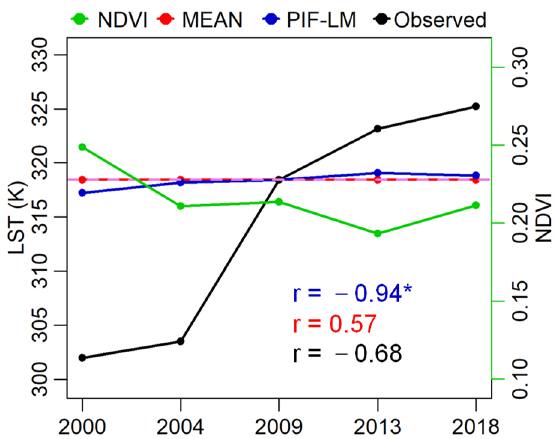
Figure 9. Temporal changes of observed LST (black line), PIF-LRM normalized LST (blue line), MEAN normalized LST (red line), and NDVI (green line) for the study area. The purple dashed line indicates the observed LST in 2009. * indicates P < 0.05, ** indicates P < 0.01.